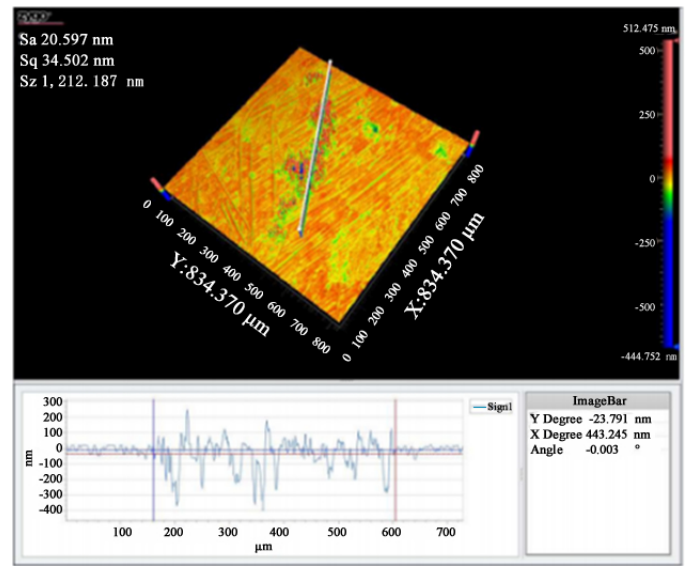
Figure 5. Damage surface and characterization under a non-shaping laser.